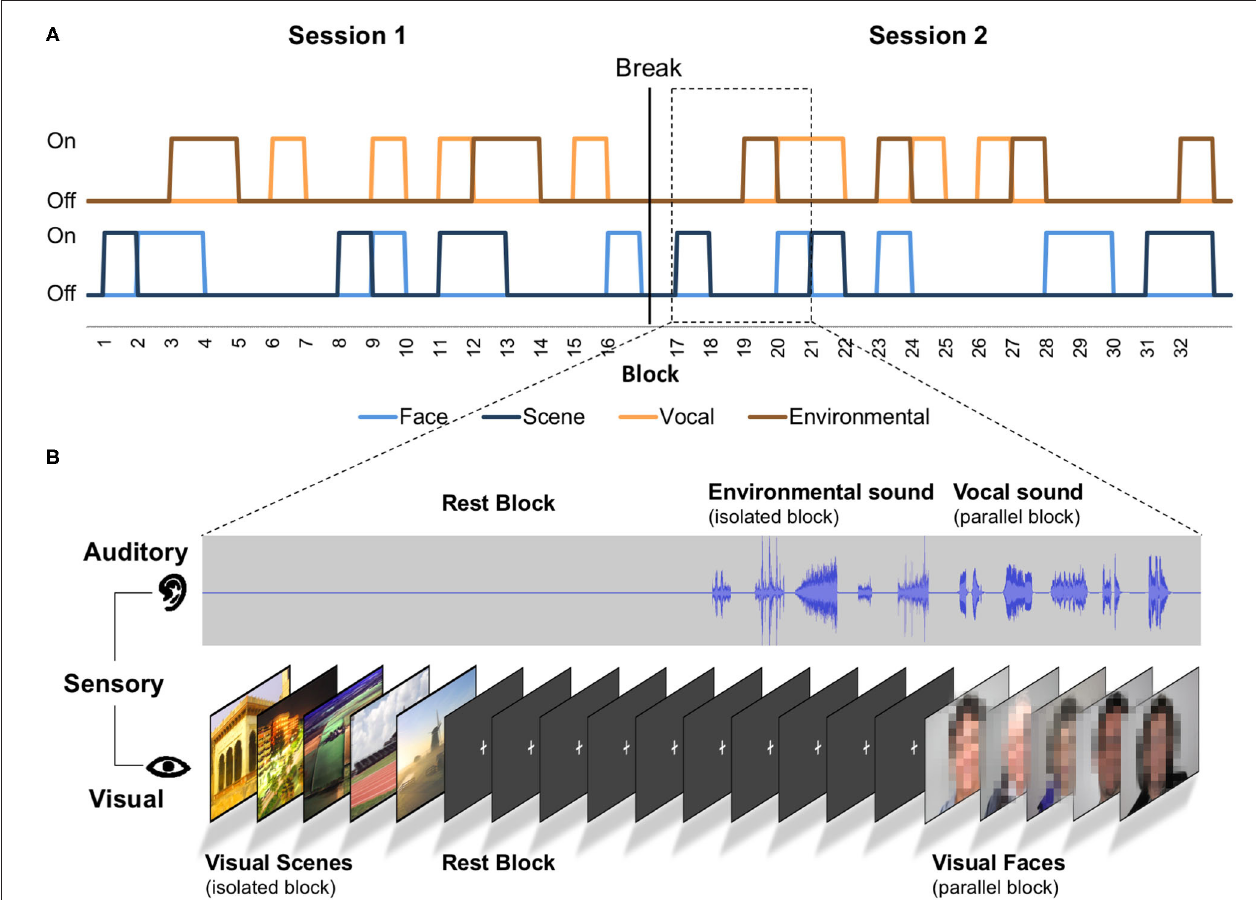
FIGURE 1 | Scheme of the task paradigm. (A) The order of presented stimuli and sensory conditions. “On” represents presentation of the stimuli, and “Off” represents no presentation of the stimuli. Each block contains five stimuli of one category and lasted 16s. In parallel conditions, five auditory and five visual stimuli are presented in one block. The auditory events consisted of environmental or vocal stimuli (see auditory timeline). The visual events consisted of face or scene stimuli (see visual timeline; faces were not pixelated in the original task). (B) Four exemplary blocks in